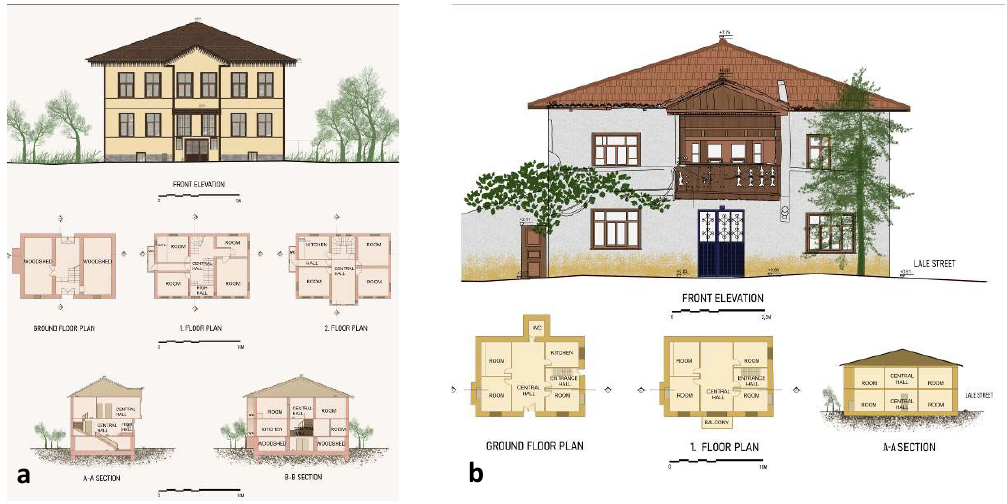
Figure 10 a A pavillion with inner sofa; b. A house with inner sofa (illustration: authors).